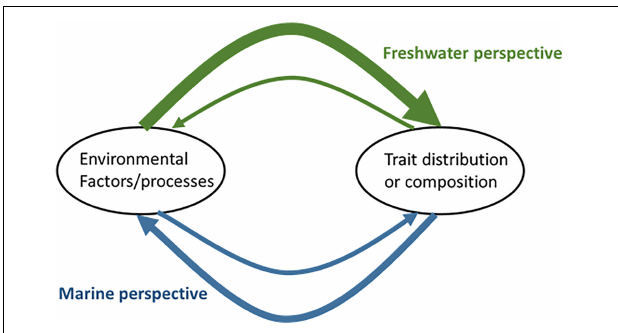
FIGURE 2 | Schematic of the pre-dominant perspectives in marine and freshwater phytoplankton trait-based research. Line thickness indicates the relative number of